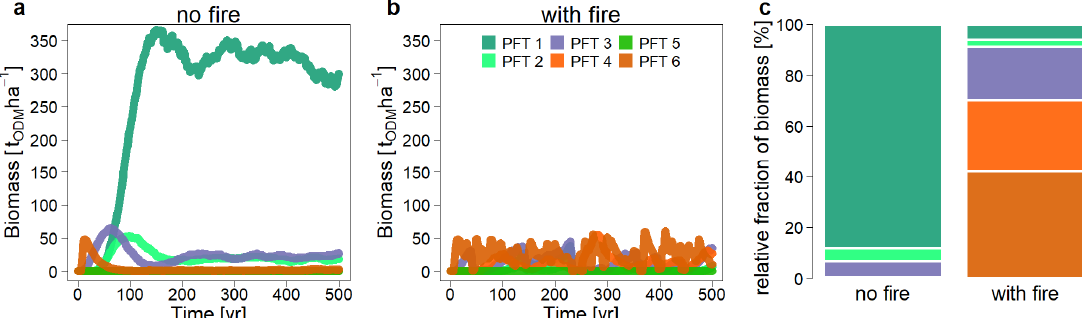
Figure 11. Simulated aboveground biomass for each plant functional type (PFT; climax green, pioneer red, mid-tolerance purple) without fire events ( a ) and after numerous fire events ( b ). On average, there is a fire in this region every 4 years. ( c ) Comparison of the species composition for an undisturbed and disturbed forest (here, the biomass fraction of each plant functional type serves as a proxy for diversity). odm = organic dry matter.